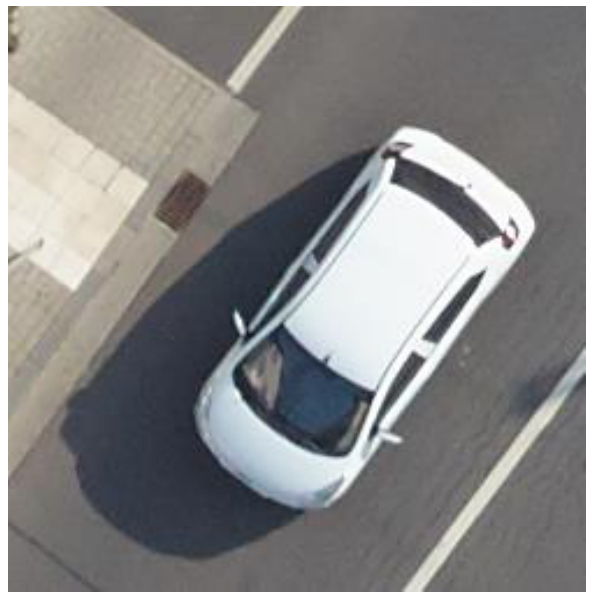
Figure 7. Detail of iXA 180 with FMC